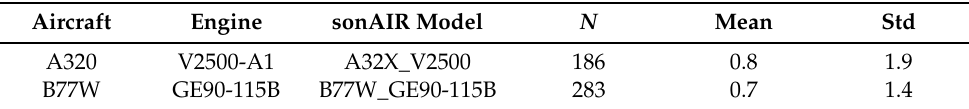
Table 2. Noise emission models used in this work for the aircraft noise simulations and their accuracy for aircraft under approach procedure: mean and standard deviation (Std) absolute differences between simulation and measurements of N flight events in terms of L AE . Source: own representation based on the work of Jäger et al. [42]. Aircraft Engine sonAIR Model N Mean Std A320